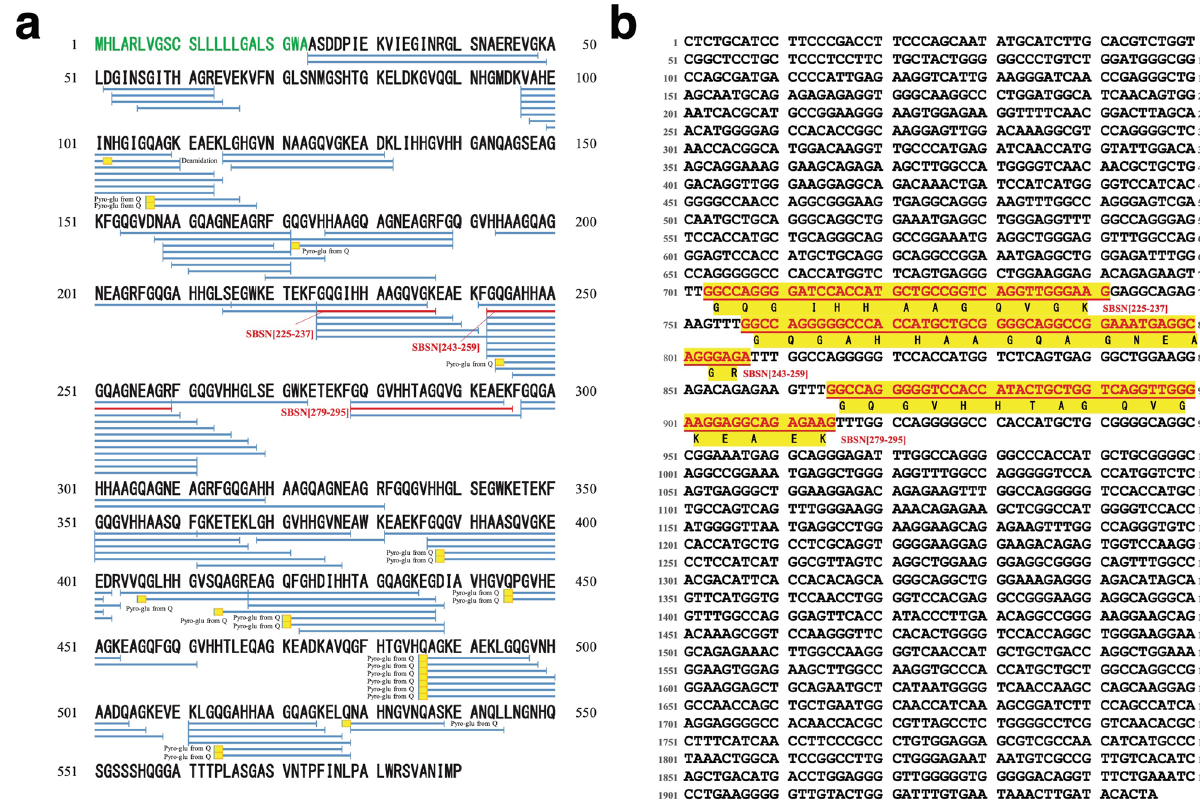
Figure 1. Peptidomic identification of suprabasin-derived native peptides in healthy human plasma. ( a ) Suprabasin and its cleaved peptide products comprehensively identified by LC–MS/MS. Red horizontal lines indicate the three detected sequences that we have shown to be potent bioactive peptides. Blue horizontal lines indicate cleaved products of prosuprabasin protein in human plasma identified with an FDR of 0% by our peptidomic analysis. The small yellow boxes denote amino acids that underwent modification. The predicted signal peptides of the preproproteins are shown in green letters. ( b ) The nucleotide sequence encoding suprabasin and the deduced amino acids of the three mature peptides. The nucleotide sequences corresponding to the three mature suprabasin-derived peptides are underlined in red and highlighted in